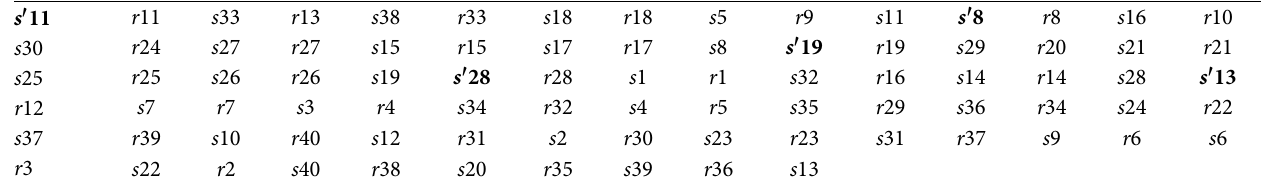
Table 9: The optimal result by GA.